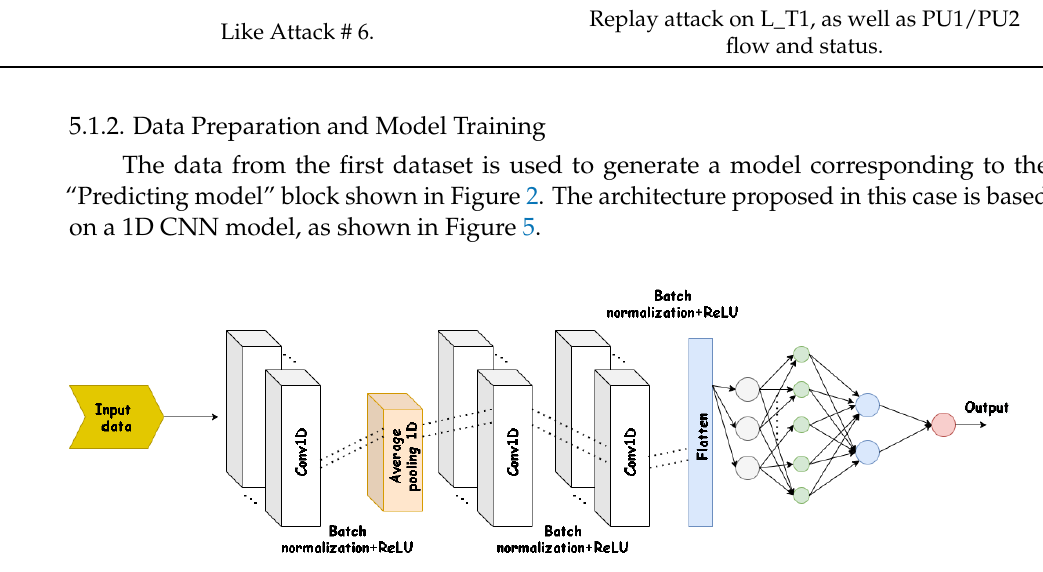
Figure 5. Prediction model for SWaT